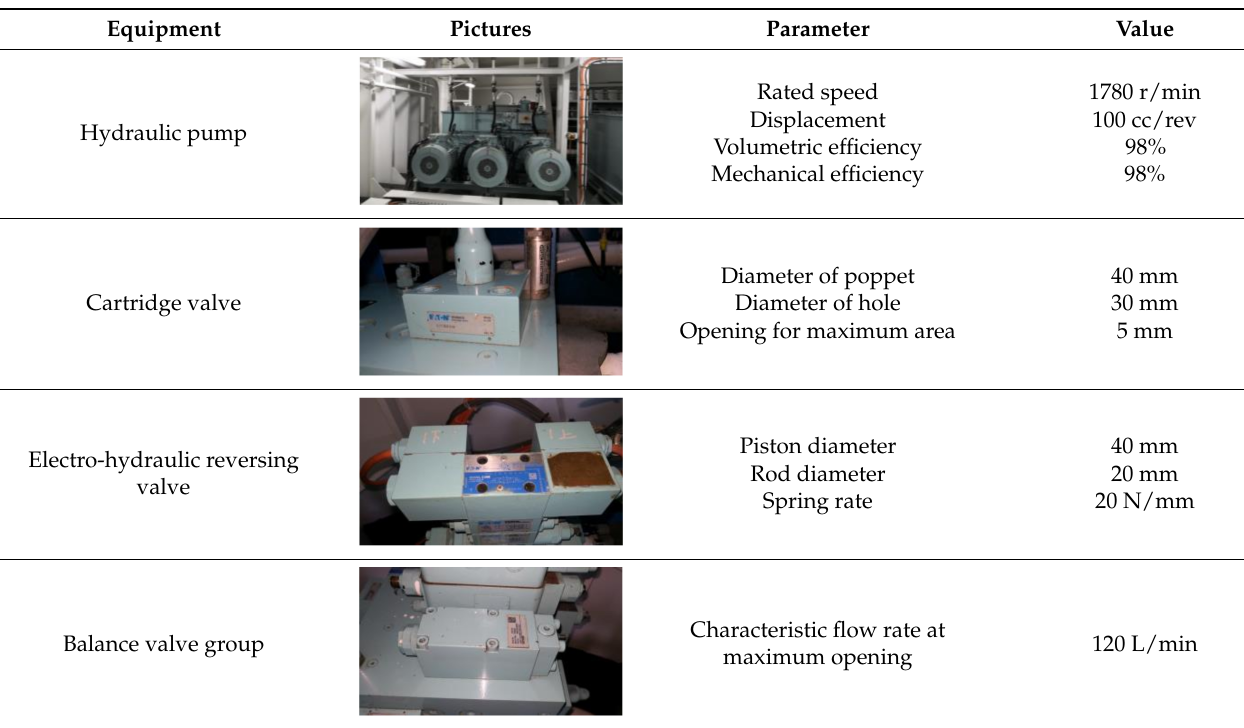
Table 2. Parameters of the hydraulic